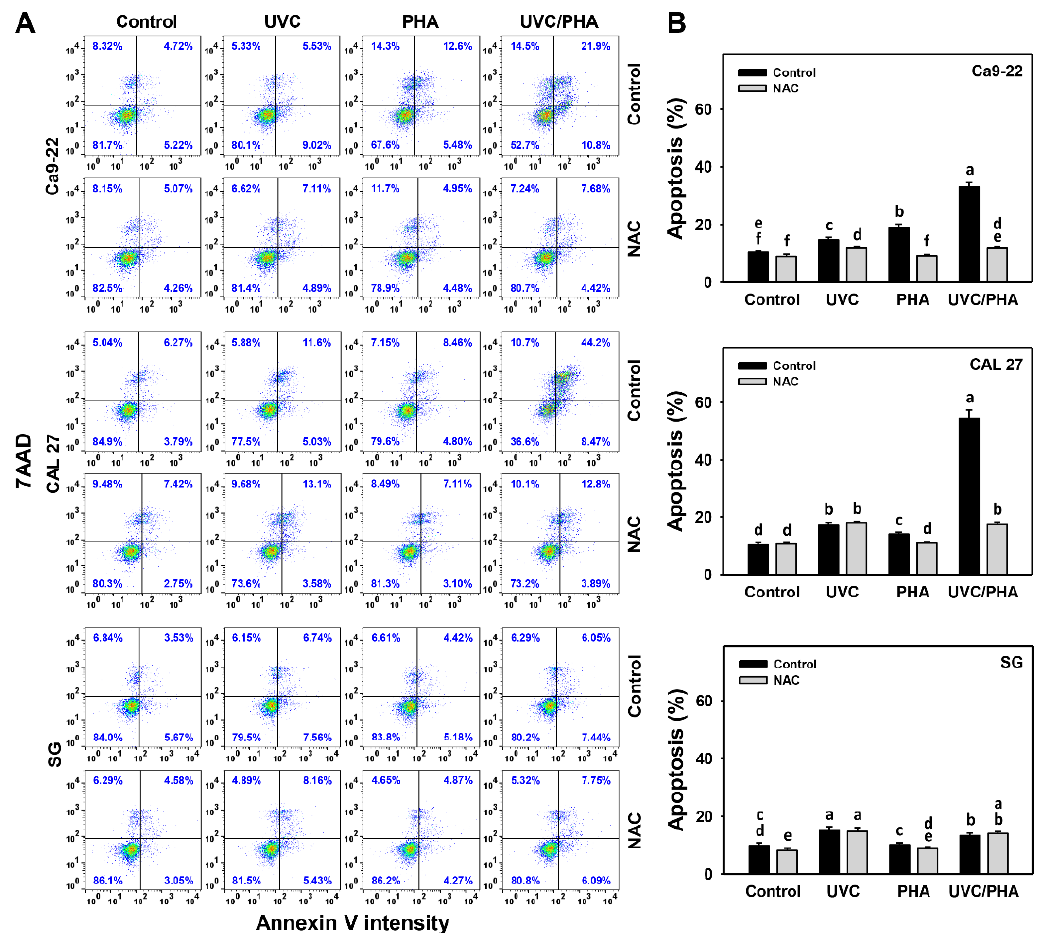
Figure 3. UVC/PHA-induced annexin-V-detected apoptosis in oral cancer cells. In the presence or absence of NAC, oral cancer and normal (SG) cells were grouped into four treatments, i.e., control, UVC, PHA, and UVC/PHA, for 24 h. The doses for the UVC and PHA treatments were 8 J/m 2 and 0.8 μ M, respectively. ( A , B ) Profile and data. Annexin-V-positive results (%) indicated apoptosis (%). For comparison, treatments labeled with different letters (a to f) produced significantly different results ( p < 0.05). Data are presented as mean ± SD ( n = 3 independent experiments, with each experiment involving 5000 gated cell counts).